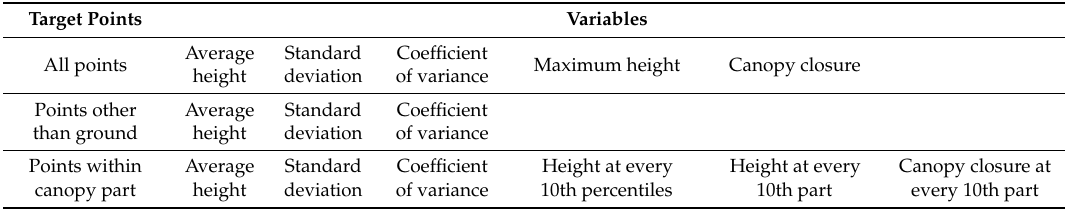
Table 3. Variables computed from LiDAR point